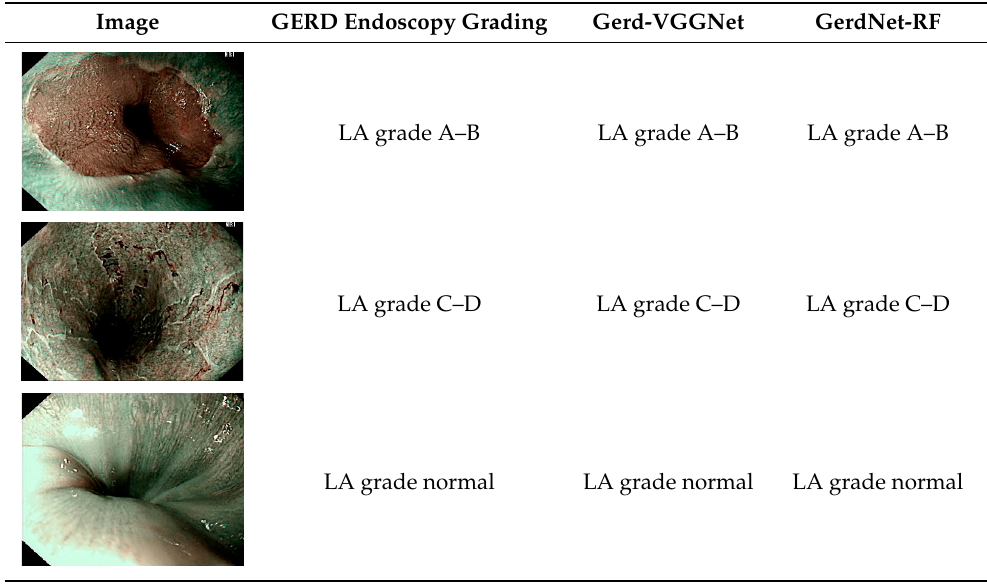
Table 6. Three types of examples where both models predict correctly.